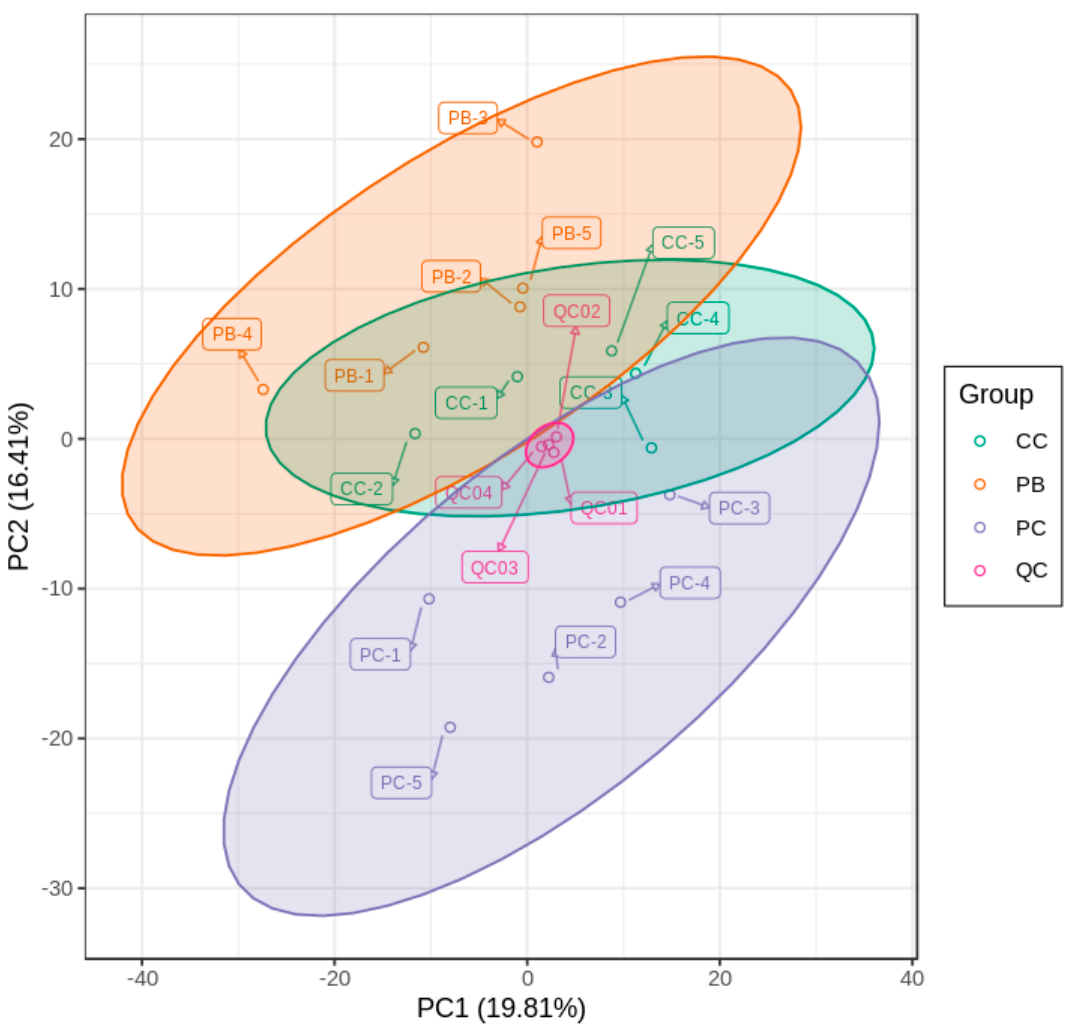
Figure 1. Score plot of principal component analysis (PCA) for D. officinale samples planted in pine bark (PB), coconut coir (CC), pine bark: coconut coir 1:1 mix (PC), and quality control (QC) samples. PC1 represents the first principal component and PC2 represents the second principal component.